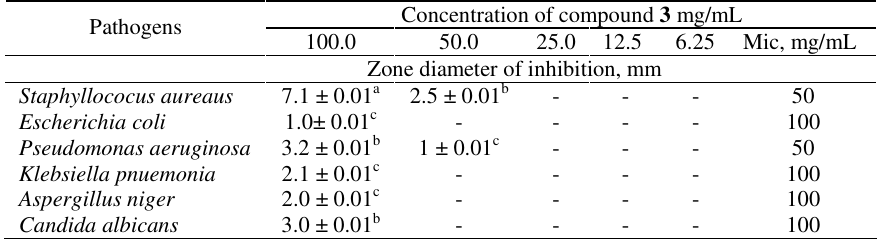
Table 2. Diameter of zones of inhibition (mm) of compound 3 isolated from Bryophyllum pinnatum